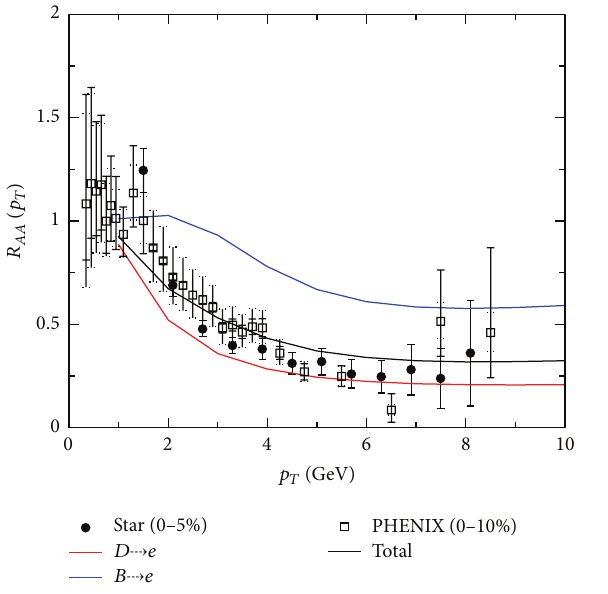
Figure 8: Variation of 𝑅 𝐴𝐴 with 𝑝 𝑇 for for 𝑐 2 𝑠 = 1/3 and 𝑇 𝑖 = 300 MeV (colour online).